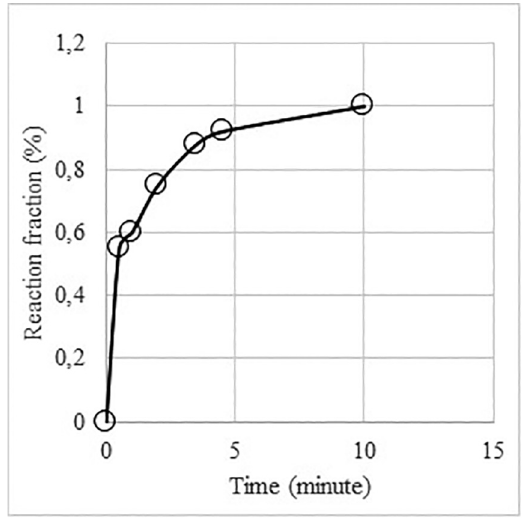
Figure 7: Reduction evolution at 1773 K of the pellet P7.